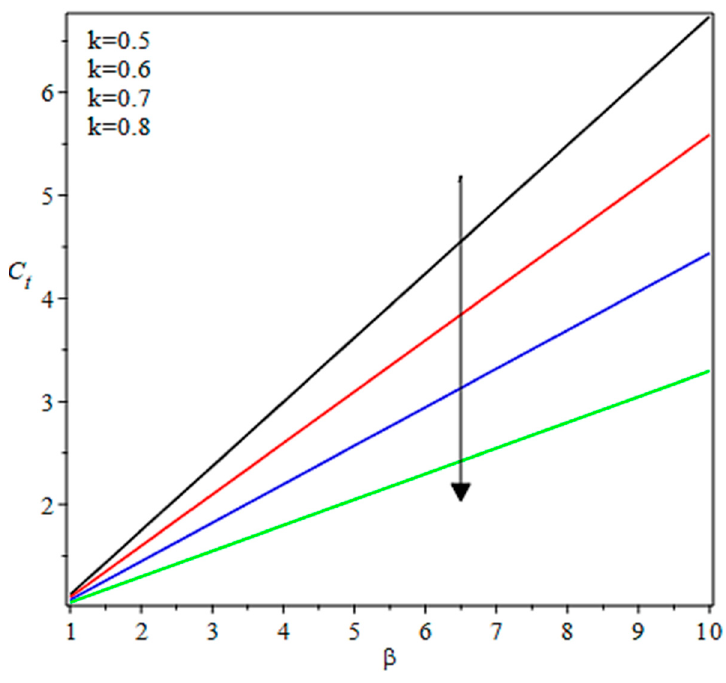
Figure 30. Influence of the velocities ratio K on the coating thickness.